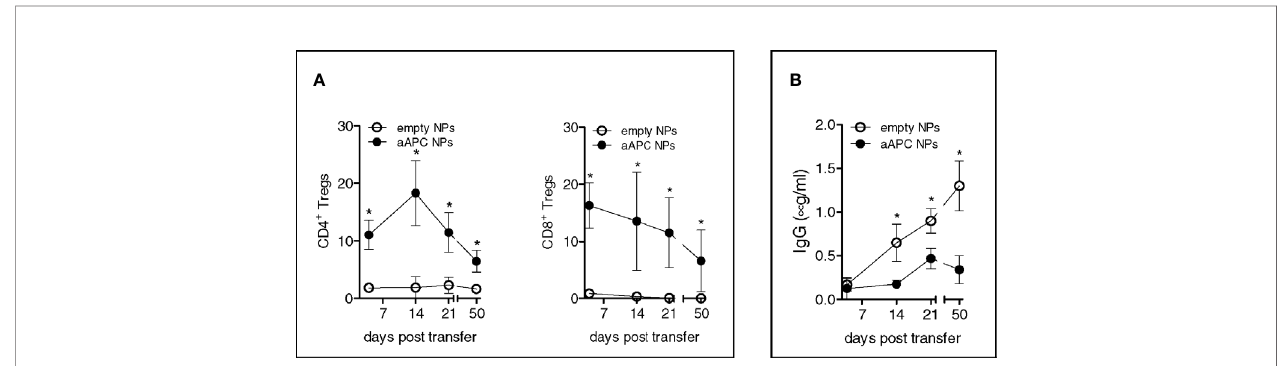
FIGURE 3 | Humanized NSG mice treated with aAPC NPs have increased numbers of circulating CD4 + and CD8 + Tregs and reduced levels of human IgG. Individual NSG mice (n = 12) that received i.v. 10 7 human PBMCs each for the induction of lupus-like disease were divided into two groups of 6 mice each. One group received IL-2/TGF- b -loaded NPs targeted to T cells (decorated with anti-CD3 Ab), the other group that served as control received empty, untargeted NPs according to the protocol detailed in the Methods . (A) PBMCs were analyzed ex vivo by fl ow cytometry at the time points indicated. Relative frequency of peripheral CD4 + and CD8 + Tregs was derived from counts of CD4 + and CD8 + T cells. (B) Human IgG antibodies in plasma were measured by ELISA. *P < 0.05 by the Student ’ s t